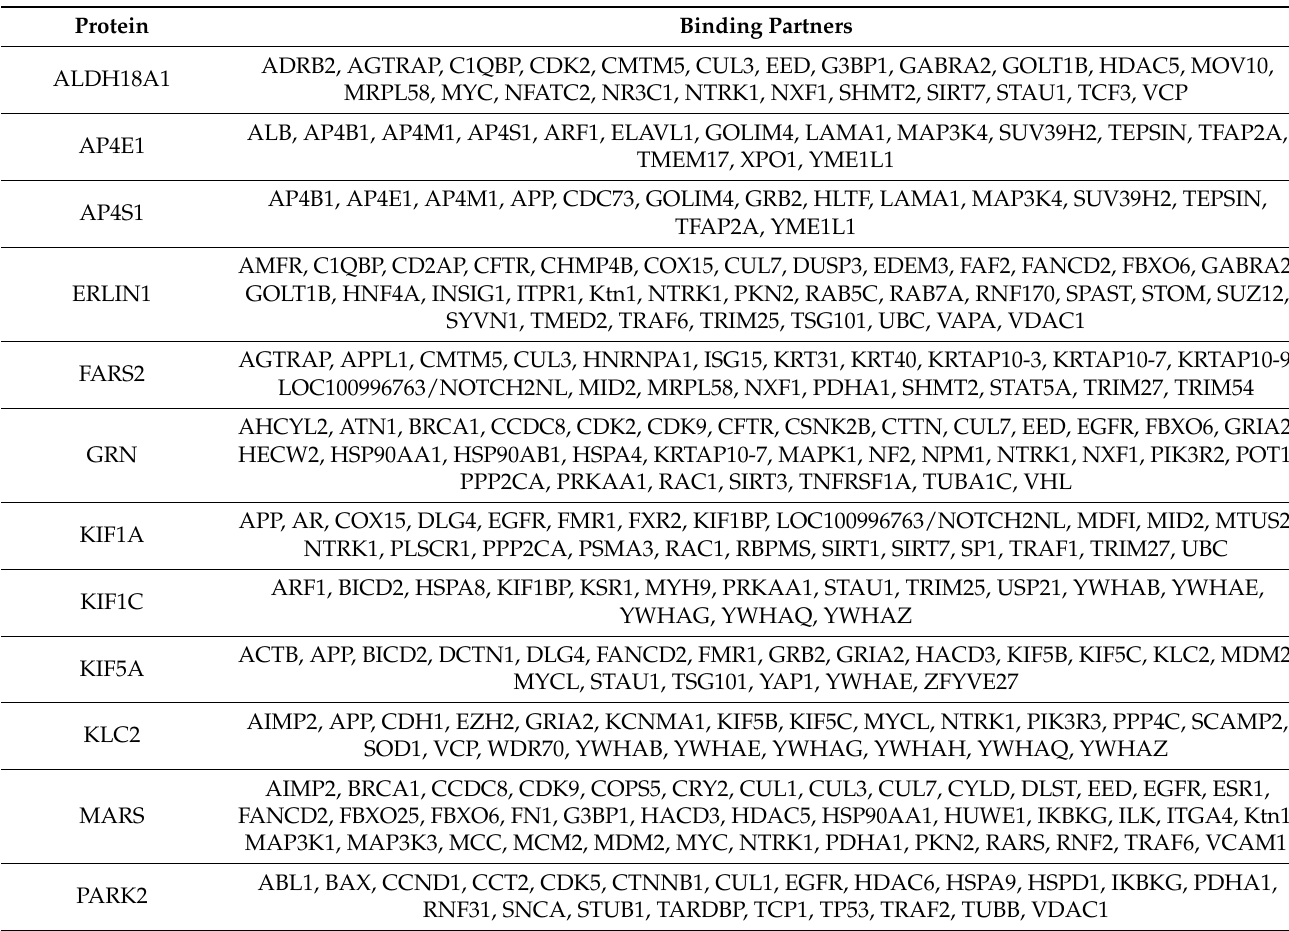
Table 2. Examples of proteins that are coded by the mutated genes detected in HSP and PLS patients, and their binding partners. Please see Supplementary Table S2 with the complete list, associated with